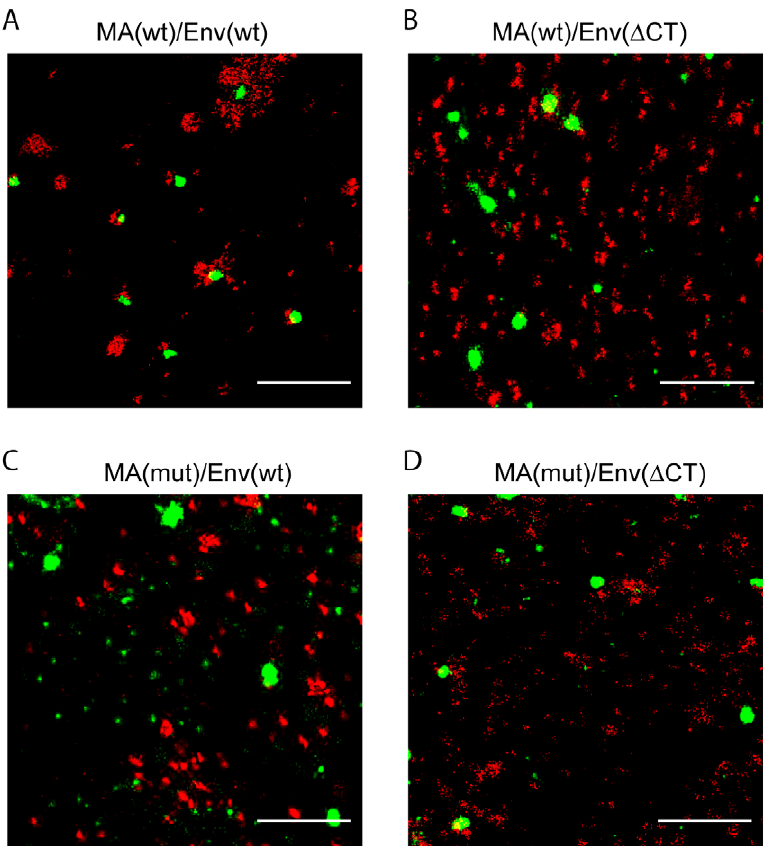
Figure 5. Distribution of Env(wt) or Env( D CT) in the context of an Env-interaction deficient Gag variant. HeLa cells were transfected with proviral constructs carrying both wt Gag and wt Env ( A ), wt Gag and Env( D CT) ( B ), Gag carrying the MA mutation and wt Env ( C ), or comprising both mutated MA and Env( D CT) ( D ), respectively. Fixed cells were stained by indirect immunofluorescence using MAb APR342 and goat anti-mouse Alexa Fluor 532 and MAb 2G12 and goat anti-human Alexa Fluor 647, and subjected to dual-color dSTORM. Scale bar corresponds to 1 m m. An overview of respective cells is presented in Figure S7.